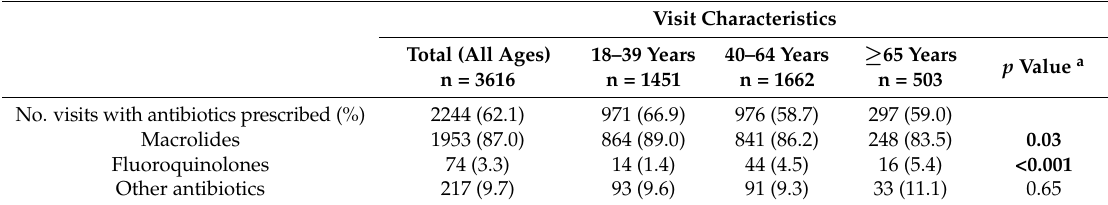
Table 2. Comparison of antibiotic classes between different age groups for adults with acute uncomplicated bronchitis treated with antibiotics,